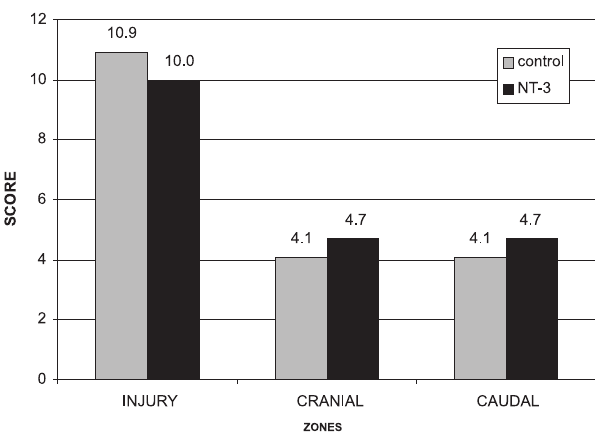
Table 6 - Final histological score, NT-3 group